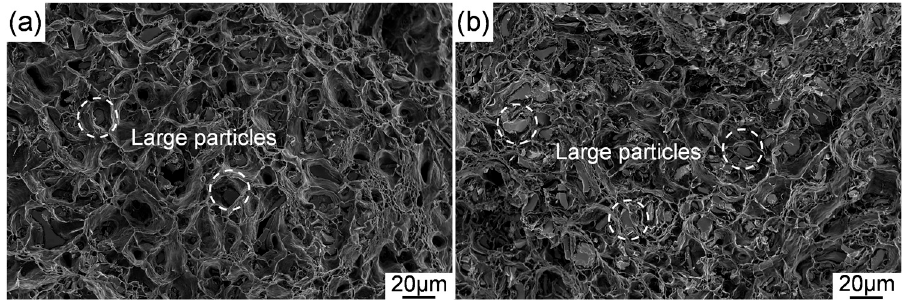
Figure 10. Tensile fracture of as-extruded alloys: ( a ) Mg-11Li-4Y-2Er-2Zn and ( b ) Mg-11Li-8Y-4Er- 4Zn.